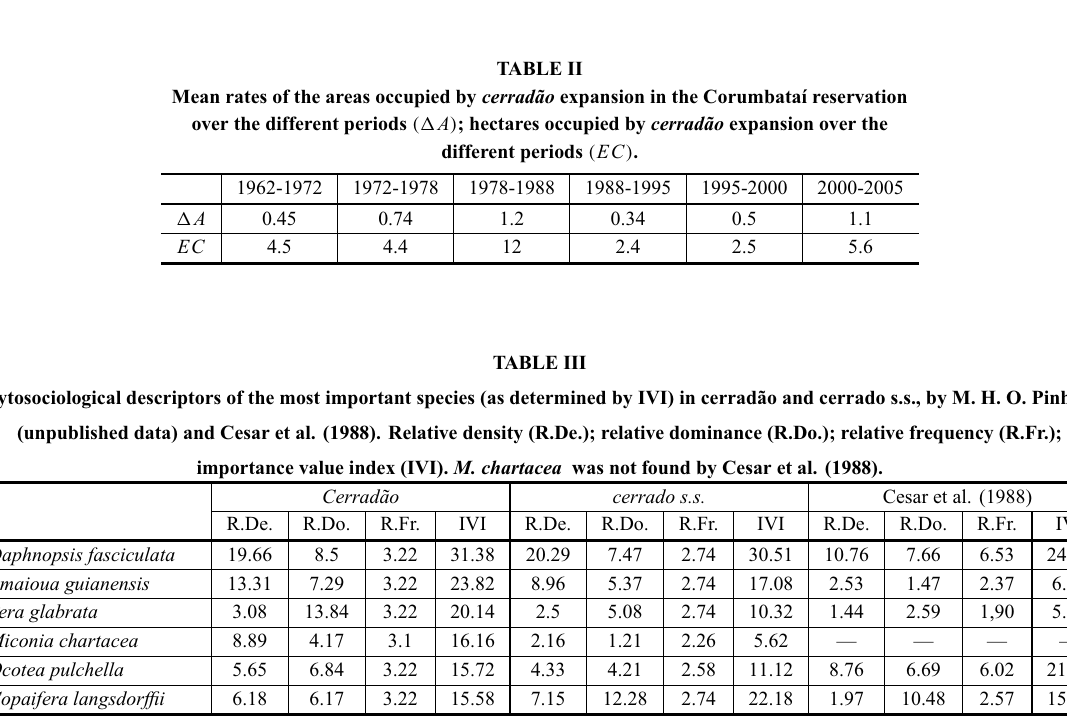
Fig. 4 – Isopletic maps showing variations in the distribution (%) of the four edaphic textures studied (clay, silt, fine sand and coarse sand) as determined by ordinary kriging.